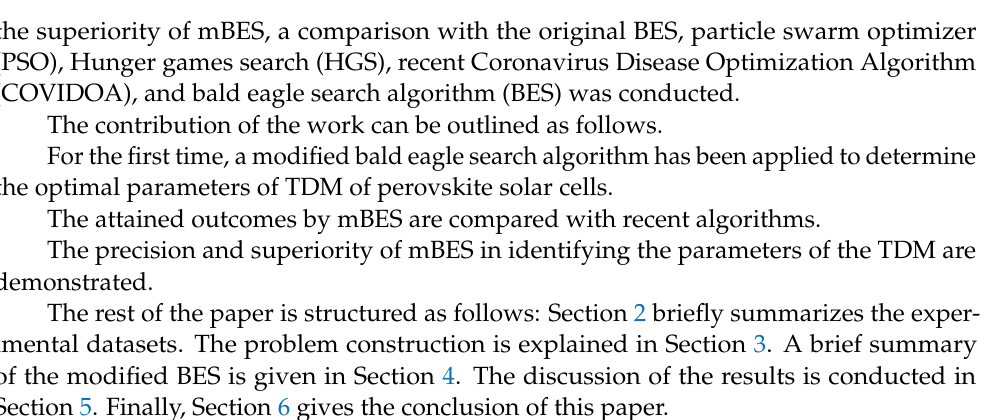
Figure 2. TDM of a solar cell. From Figure 2, the output current of the solar cell can be estimated by the subsequent relation: